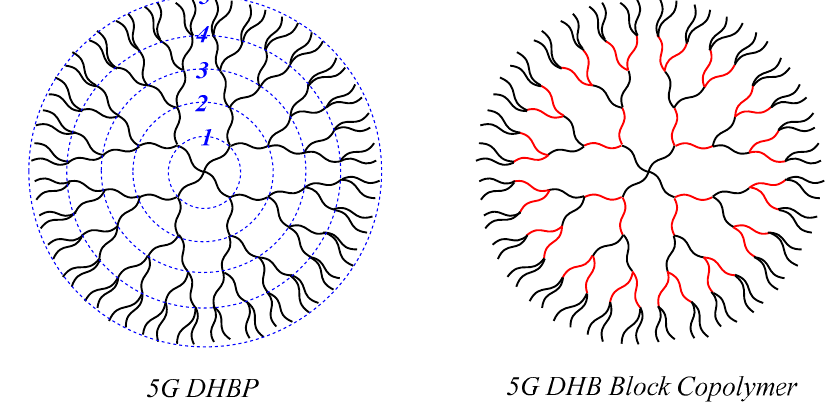
Figure 1. 5G (DHBP) and its block copolymer.